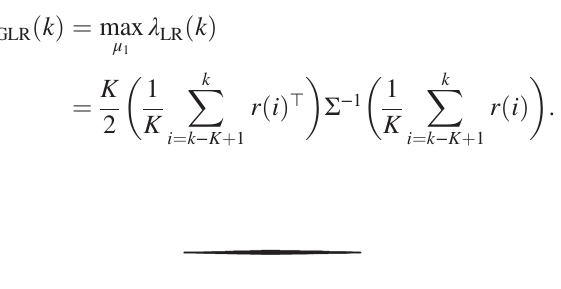
from the given nominal data, the mean μ 1 is unknown. For estimating μ 1 , the maximum log-likelihood ratio, i.e., generalized likelihood ratio (GLR), is considered. This is derived in (10) from (A1) by replacing μ 1 with its maximum likelihood estimate, given as [27]